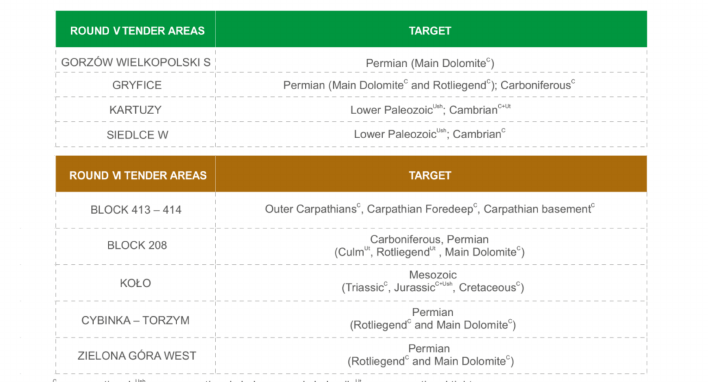
Figure 2. Concessions for prospecting and exploration of hydrocarbon deposits together with concessions for prospecting and exploration of hydrocarbon deposits and production of hydrocarbons from deposit in relation to tender areas dedicated to 5th and 6th tender round and petroleum provinces of Poland.